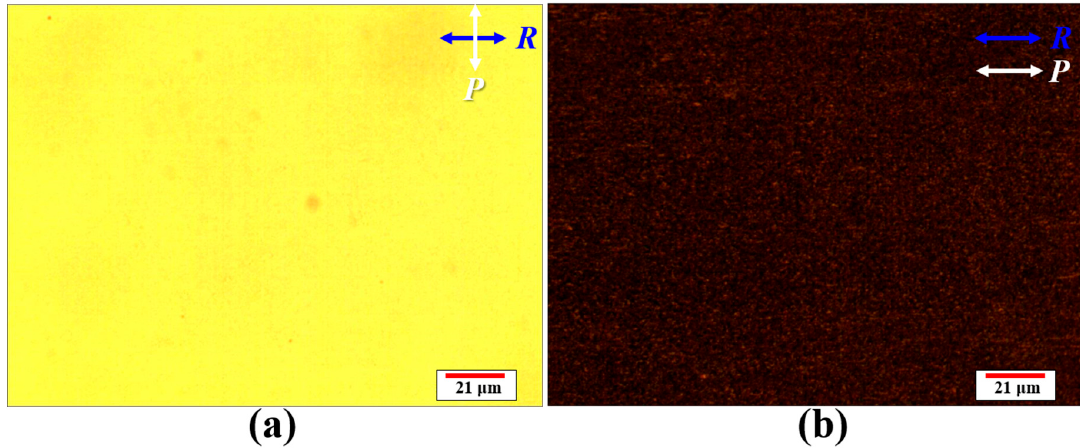
Figure 7. Hysteresis of the T–V curve of the H-PNLC cell measured by the unpolarized He–Ne laser. The applied AC field is a square-wave field with a frequency of 1 KHz.